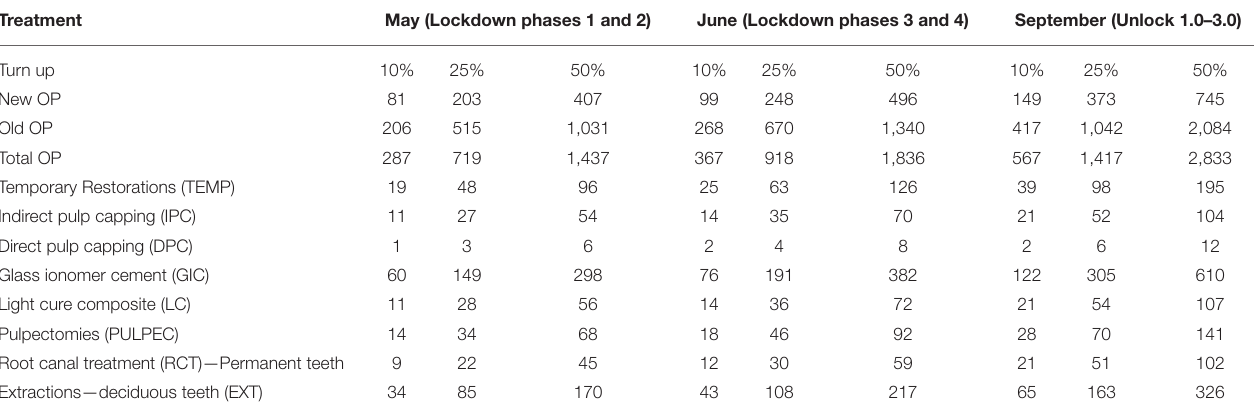
TABLE 2 | Initial baseline prediction and possible care-seeking